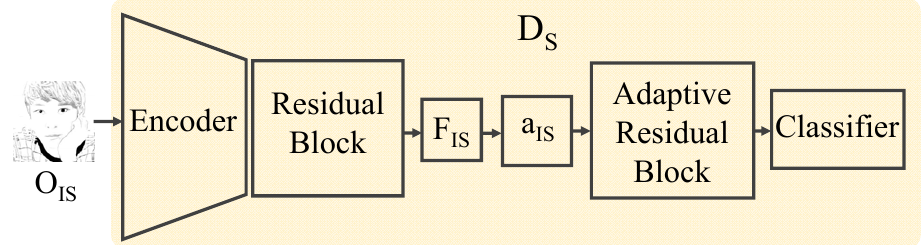
Figure 5. The structure of our